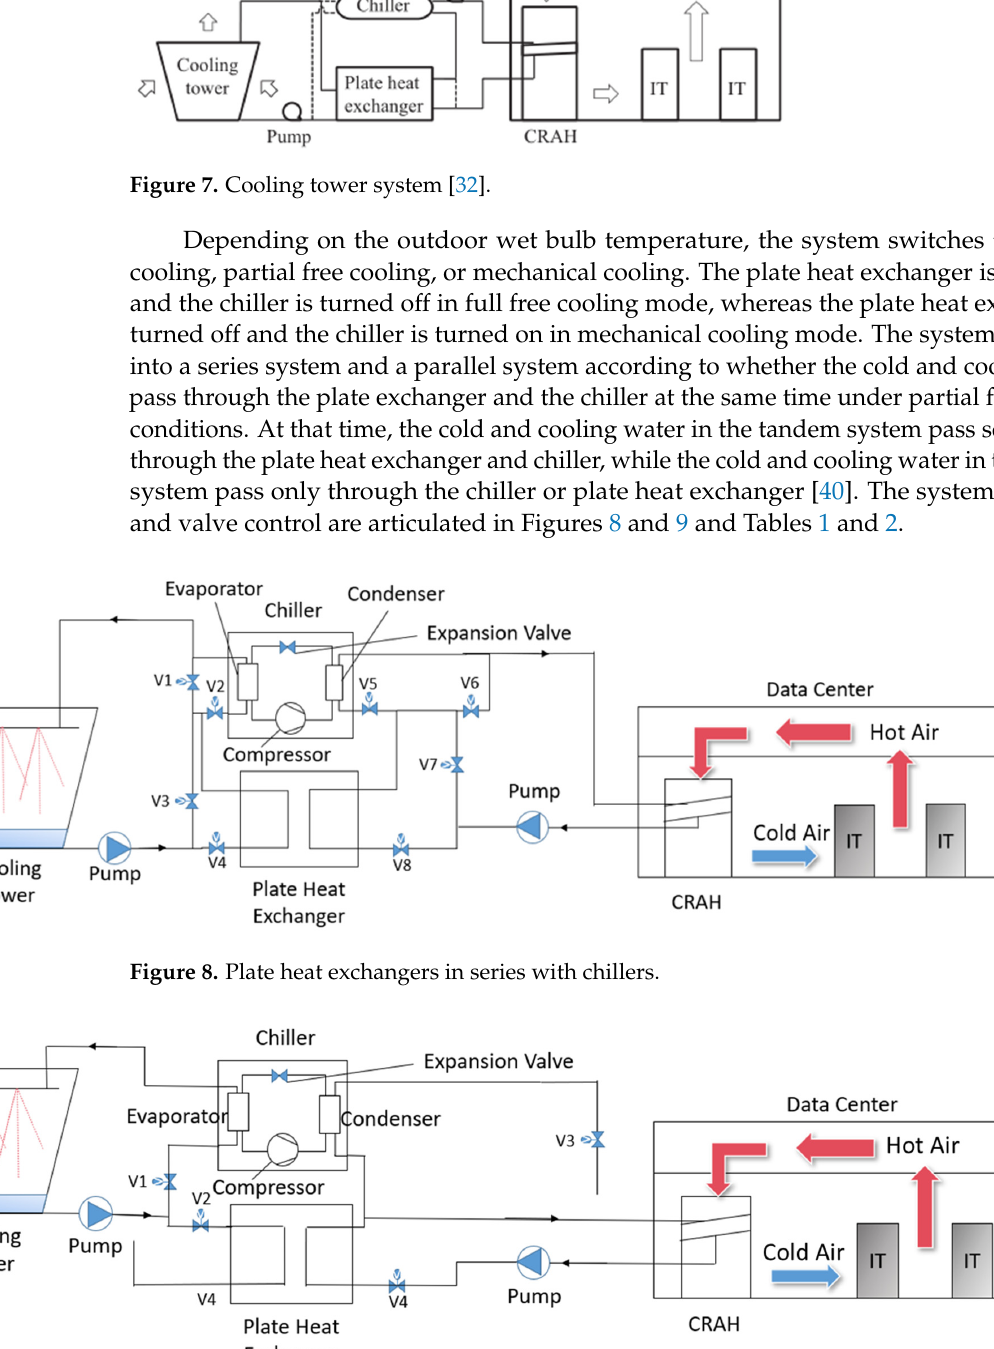
Figure 6. Two types of air-cooled systems working as water-side economizers : ( a ) independ- ent dry cooler; ( b ) integrated dry cooler with air-cooled chiller.